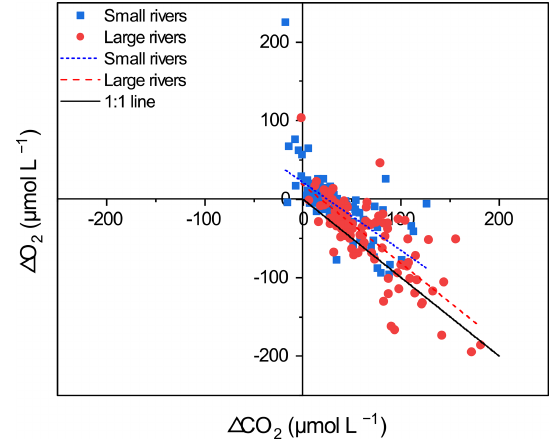
Figure 8. The relationship between (cid:49) CO 2 and (cid:49) O 2 . Points greater than zero are oversaturated, and points less than zero are under- saturated. Points above the 1 : 1 line indicate the existence of ad- ditional carbon sources, apart from in-stream metabolic processes. For large rivers, the linear regression is (cid:49) CO 2 = − 0 . 999 ( ± 0.081) (cid:49) O 2 + 18 . 020 ( ± 5.995) ( r 2 = 0 . 62, p< 0 . 001). For small rivers, the linear regression is (cid:49) CO 2 = − 0 . 868 ( ± 0.098) (cid:49) O 2 + 21 . 42 ( ± 4.175) ( r 2 = 0 . 41, p <